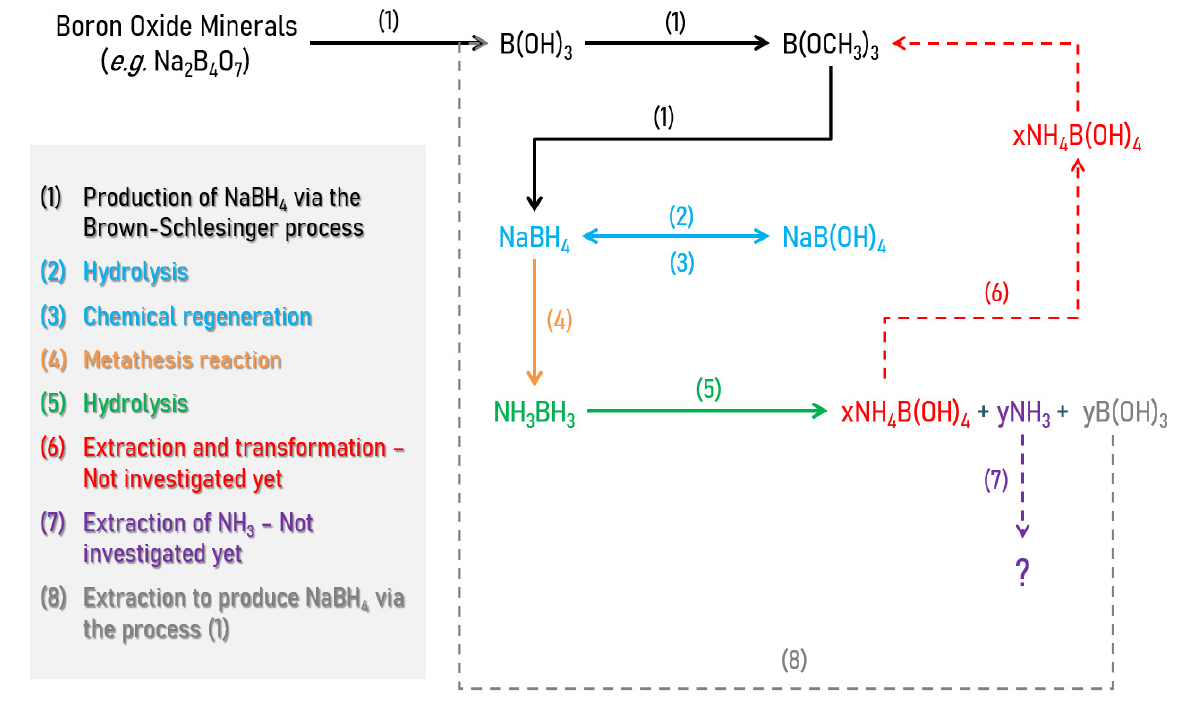
Figure 3. Sodium borohydride vs. ammonia borane for H 2 generation via hydrolysis at ambient conditions.